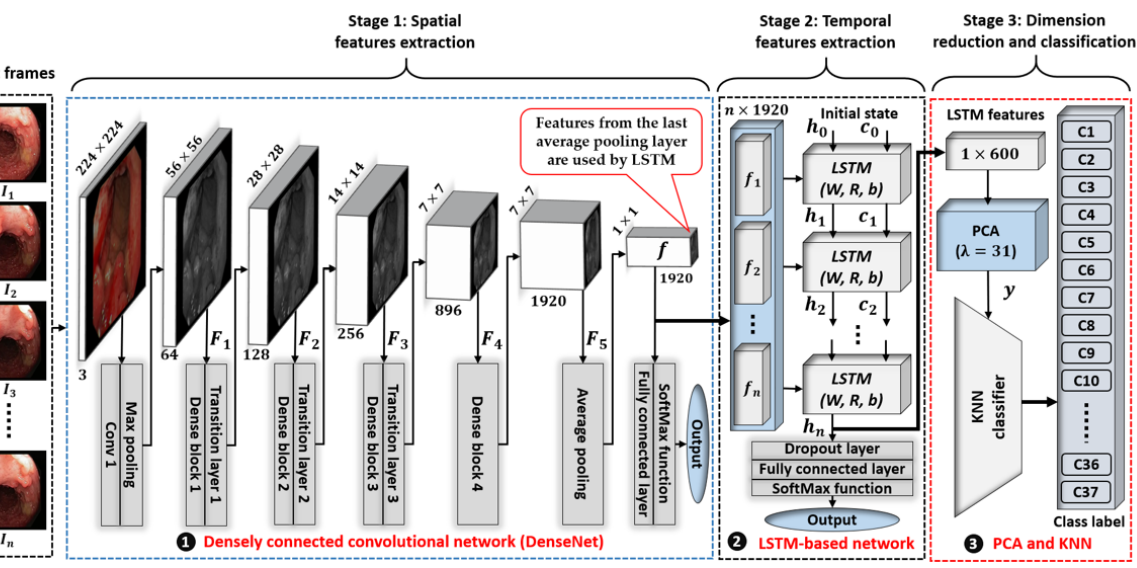
Figure 2. Overall block diagram of our proposed spatiotemporal feature–based classification network composed of DenseNet and LSTM-based networks. KNN: k-nearest neighbor; LSTM: long short-term memory; PCA: principal component